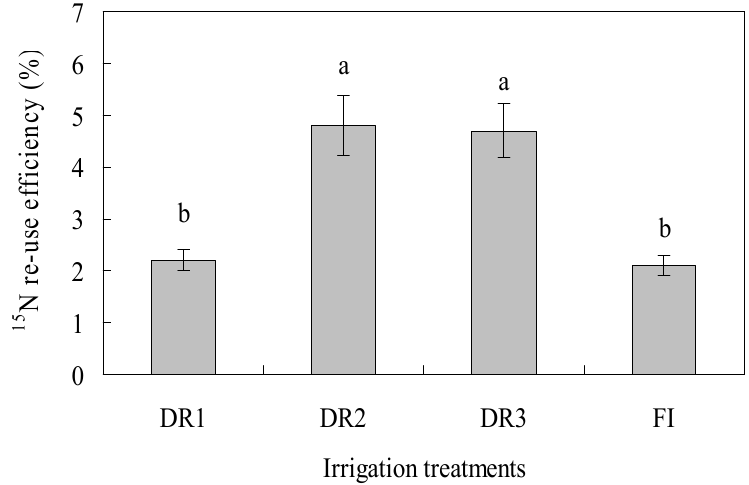
Figure 6. The lettuce-use efficiency for soil residual 15 N under different irrigation treatments (DR1, DR2, and DR3 mean the lower irrigation limits of 75%, 65%, and 55% accounting for the field capacity, separately. FI represents furrow irrigation treatment using the same irrigation regime as DR2. The data in the Figure are mean ± SD. The different letters (a, b) indicate significant differences at the level of 0.05 according to Duncan’s multiple range test).